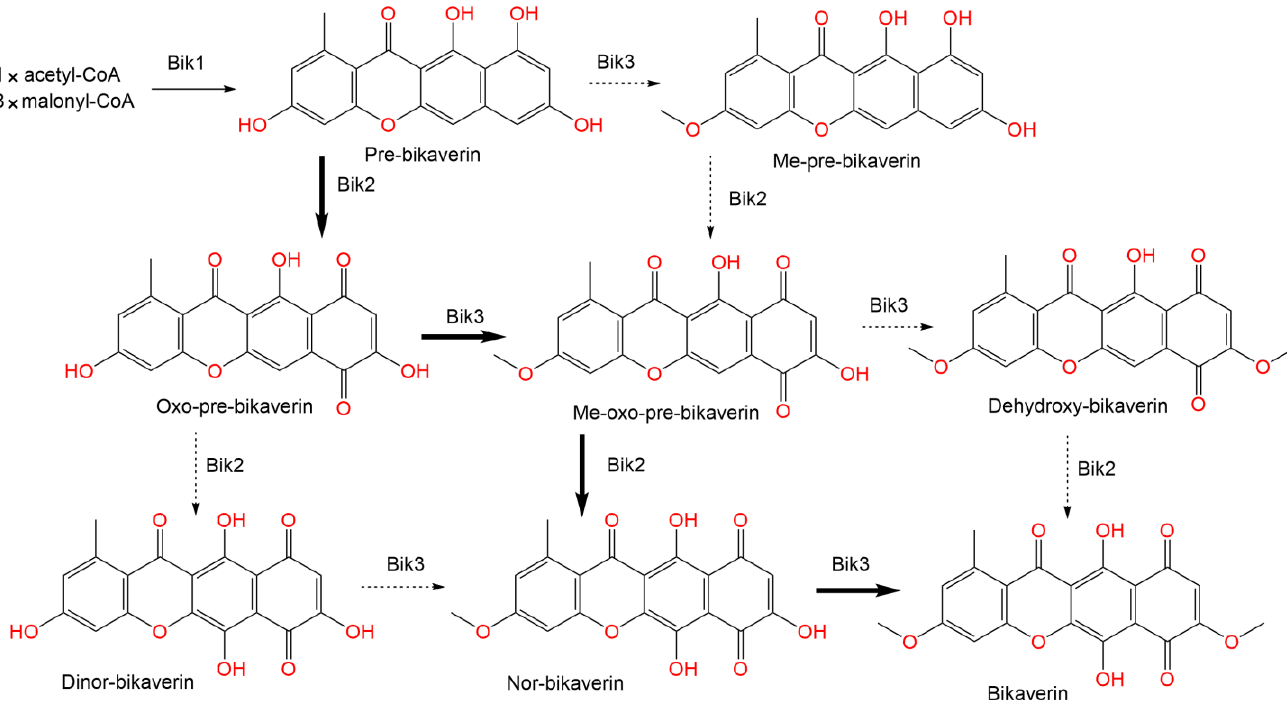
Scheme 3. Putative biosynthetic pathway of 119 and its intermediates. The bold arrows represent the preferred pathway and dashed lines represented other possible reaction steps [196 – 198].